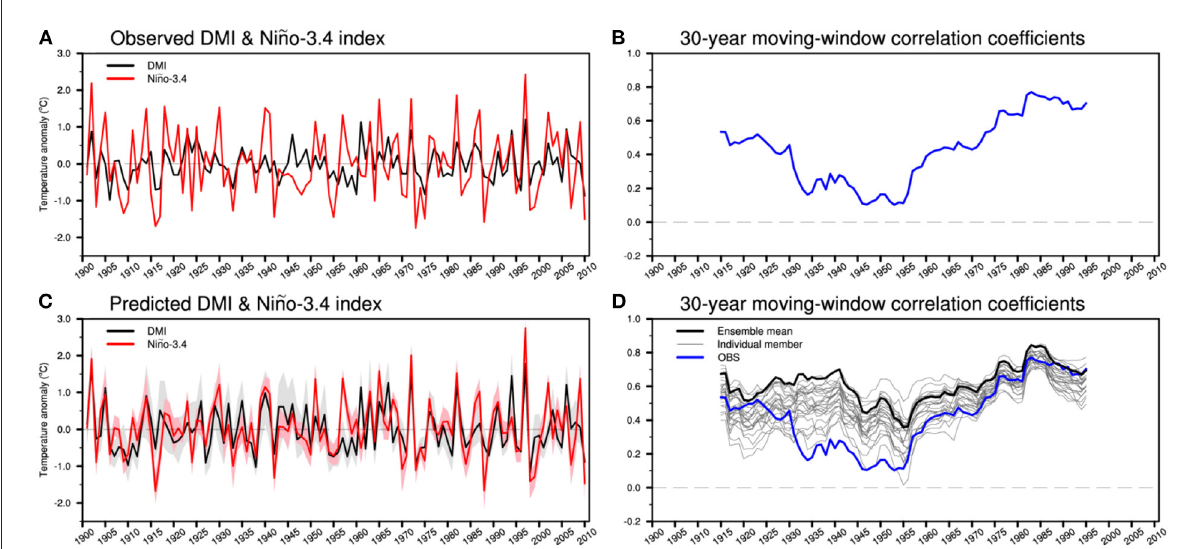
FIGURE4 (A) The observed SON-mean DMI (black line) and SON-mean Niño-3.4 index (red line) for the period 1901–2010. (B) The 30-year moving-window correlation coefficients between the observed DMI and Niño-3.4 indices. (C) The predicted SON-mean DMI (black line) and SON-mean Niño-3.4 index (red line) at 1-month lead from the CSF-20C. The red and gray shading indicates the ensemble spread of DMI and Niño-3.4 index, respectively. (D) The 30-year moving-window correlation coefficients between the predicted DMI and Niño-3.4 indices for the ensemble mean (thick black line) and individual member (thin gray line). The observation is shown in a thick blue line. For (B, D) , the correlation coefficients have been computed for 30-year windows moved across the period 1901–2010 by 1 year, and the correlations for each 30-year window are plotted at the central year.